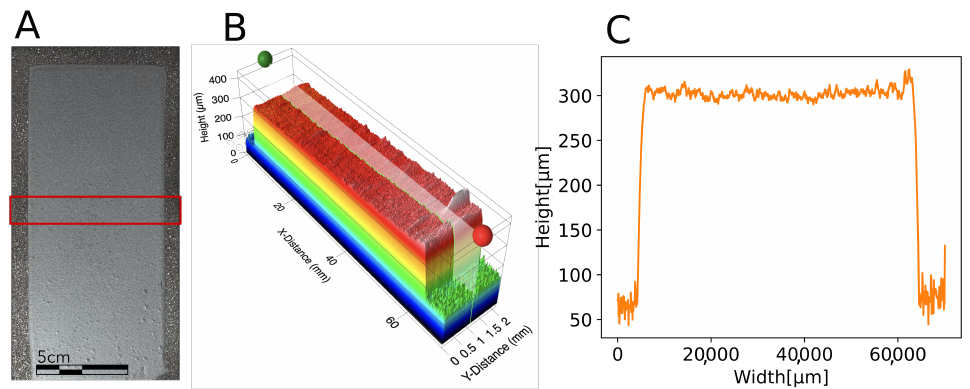
Figure 3. Determining the thickness of the given paint sample: ( A ) The sample given by Jotun. The red square indicates the area of the 3D scan. ( B ) Three-dimensional scan of the paint. ( C ) Height along the line indicated in ( B ). An average thickness can be derived from the difference in the average height between the metal and the top of the paint. For the paint sample, the average paint thickness was